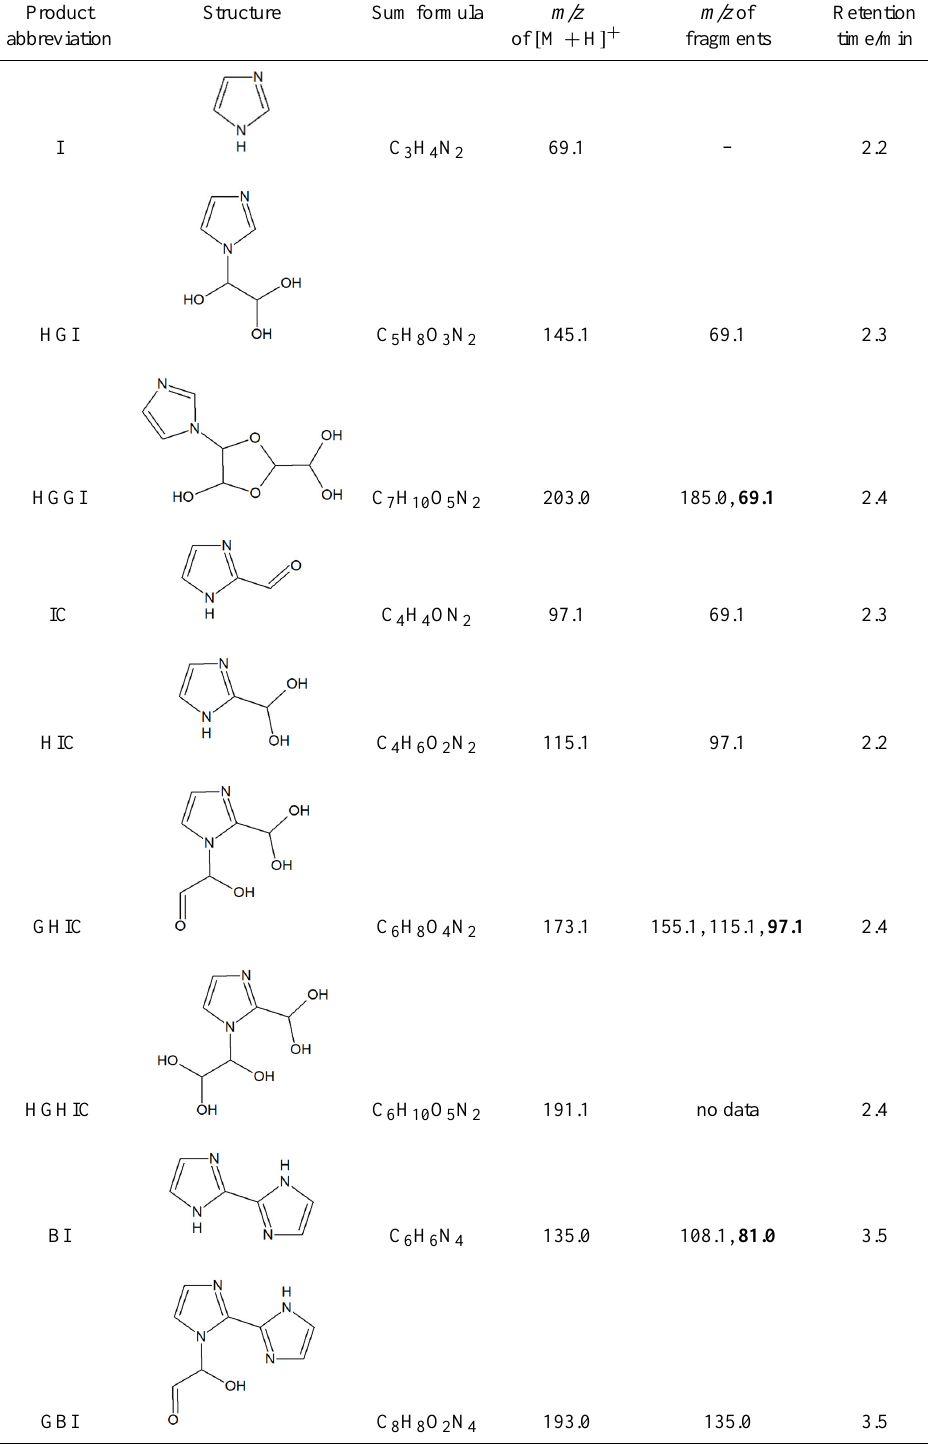
Table 1. HPLC-ESI-MS/MS characterization of imidazole products in the Gly/AS system. 2 Most abundant fragment ions are written in bold.